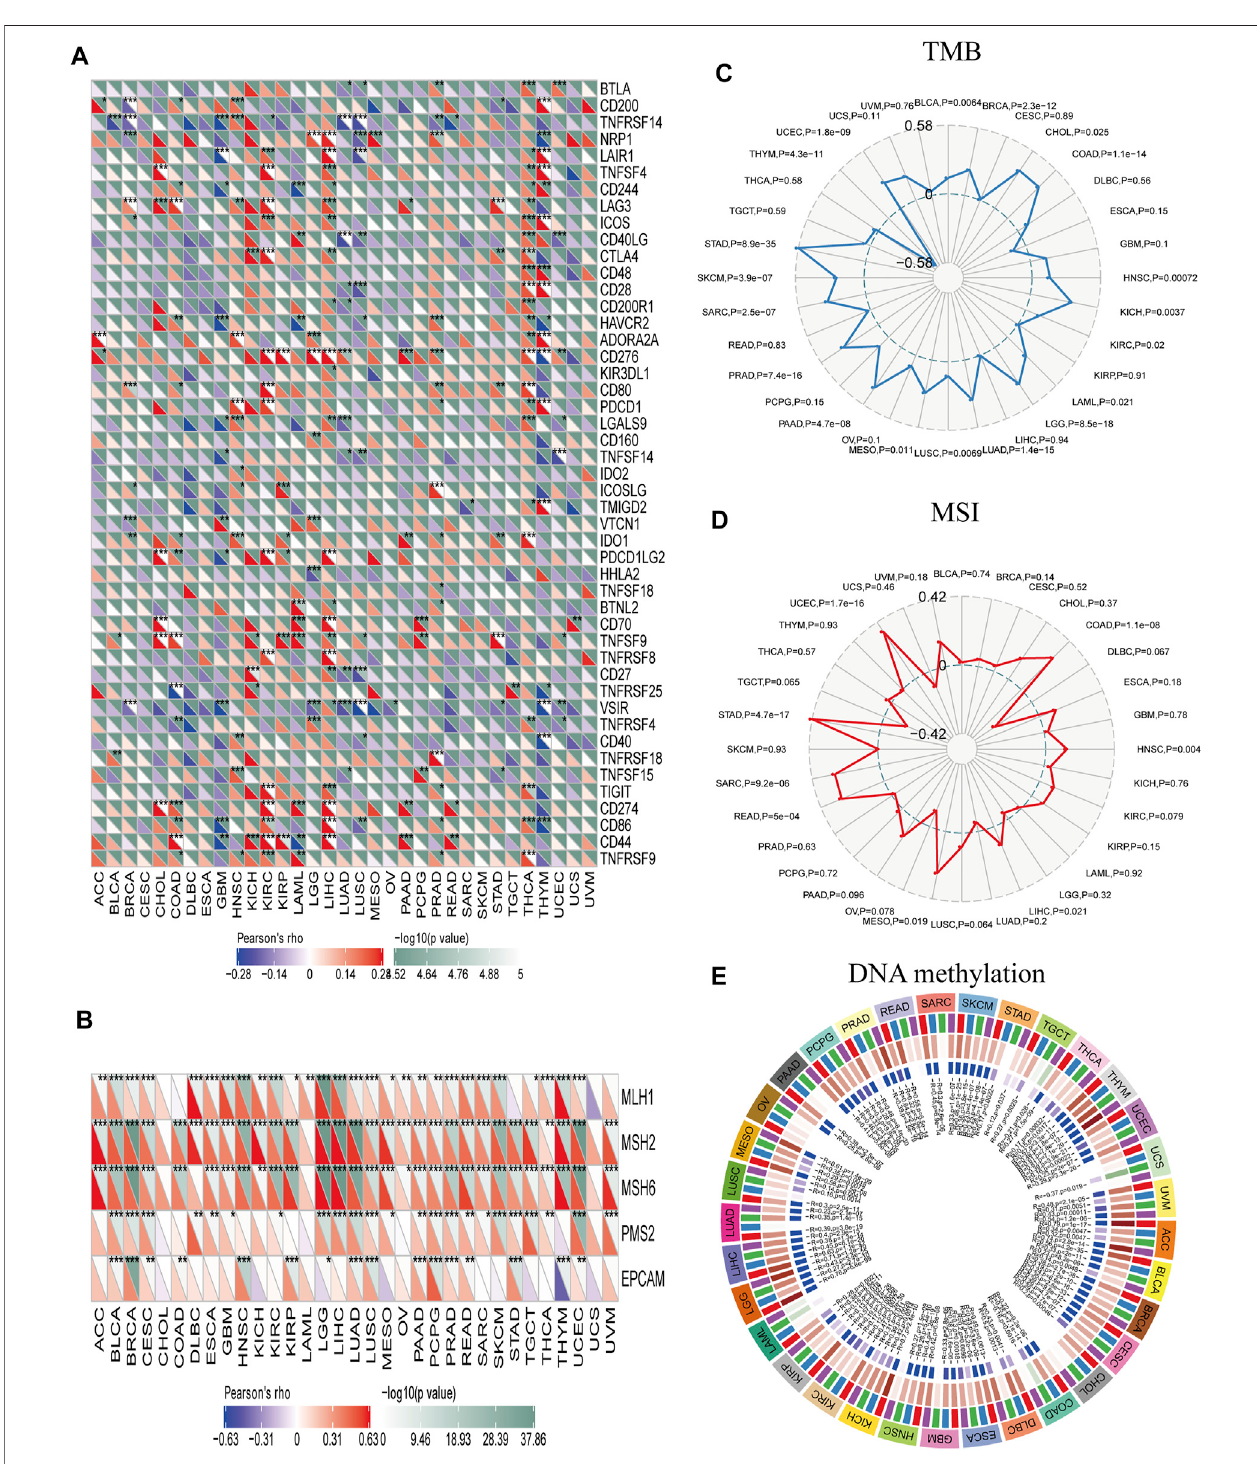
FIGURE 7 | Correlations between PBK and immune checkpoints and other variables of interest. (A – E) Correlations between PBK expression and con fi rmed immune checkpoints (A) , genes involved in MMR (B) , TMB (C) , MSI (D) , and DNA methylation (E) in multiple cancers. * p < 0.05, ** p < 0.01, *** p < 0.001.